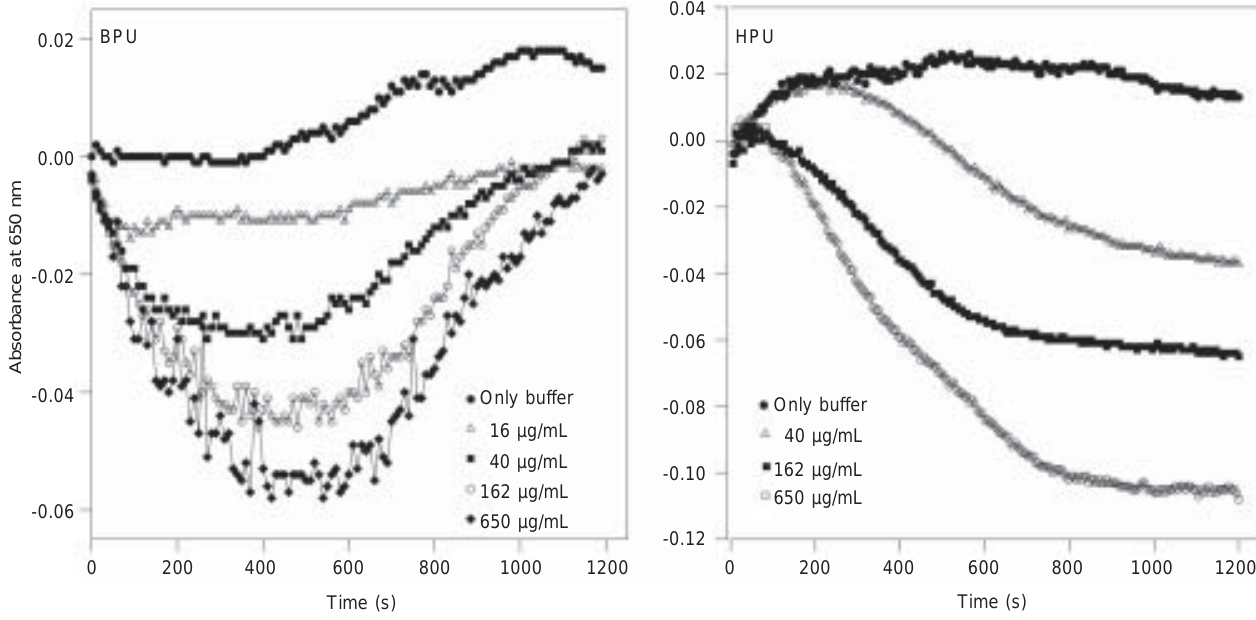
Figure 2. Dose-response curve of platelet aggregation induced by purified Bacillus pasteurii (BPU, left panel) and Helicobacter pylori ureases (HPU, right panel). Rabbit platelet-rich plasma suspensions were challenged with different concentrations of purified B. pasteurii (Sigma, St. Louis, MO, USA) or recombinant H. pylori (Ref. 44) ureases. The decrease in absorbance at 650 nm indicating platelet aggregation was monitored every 11 s for 20 min with a plate reader (13). Typical experiments are